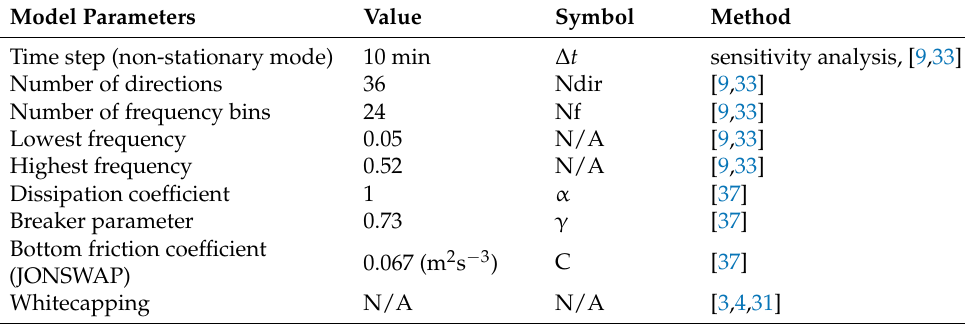
Table 2. Summary of model setup